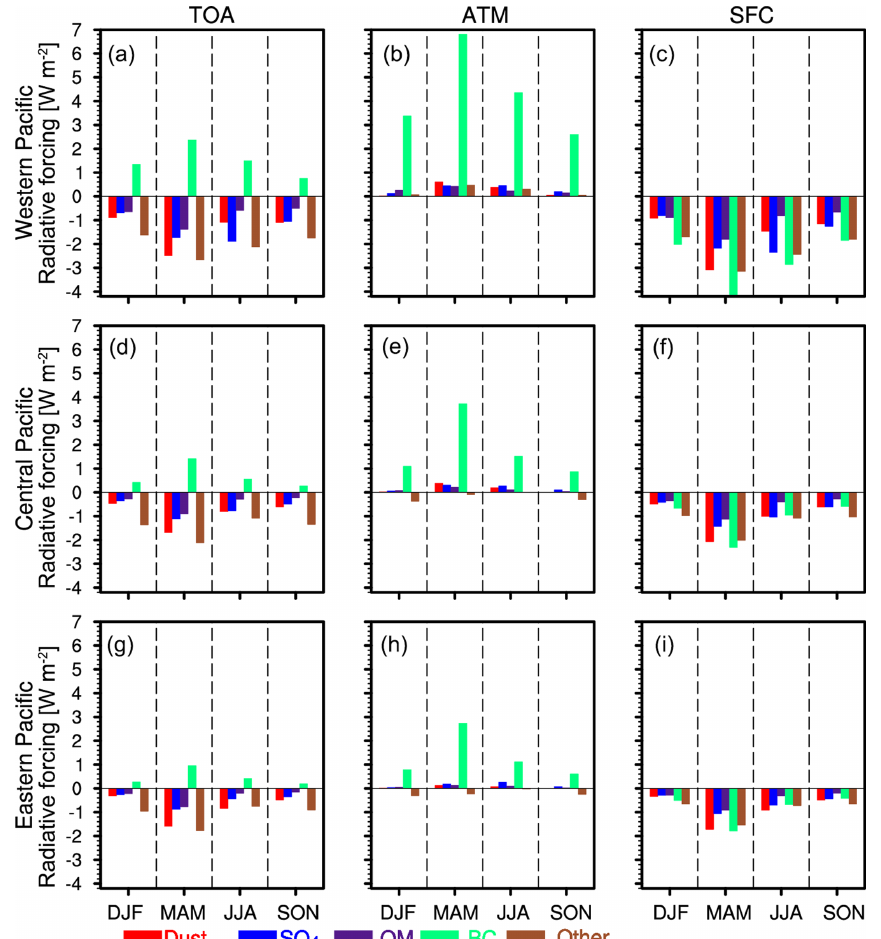
Figure 11. Seasonal variation of aerosol composition radiative forcing at the TOA (a, d, g) , in the atmosphere (b, e, h) , and at the surface (c, f, i) over the western, central, and eastern Pacific under all-sky conditions from the WRF-Chem simulation averaged for